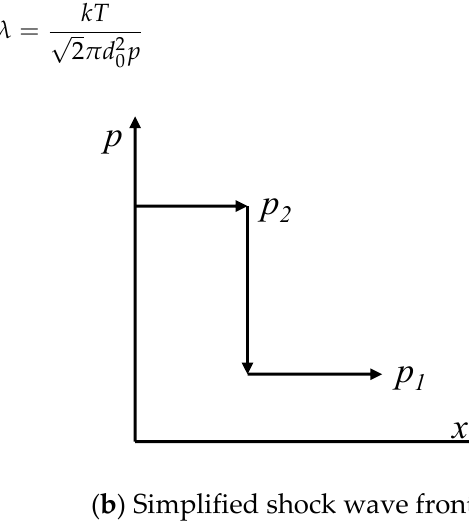
Figure 2. Wave front of a shockwave.